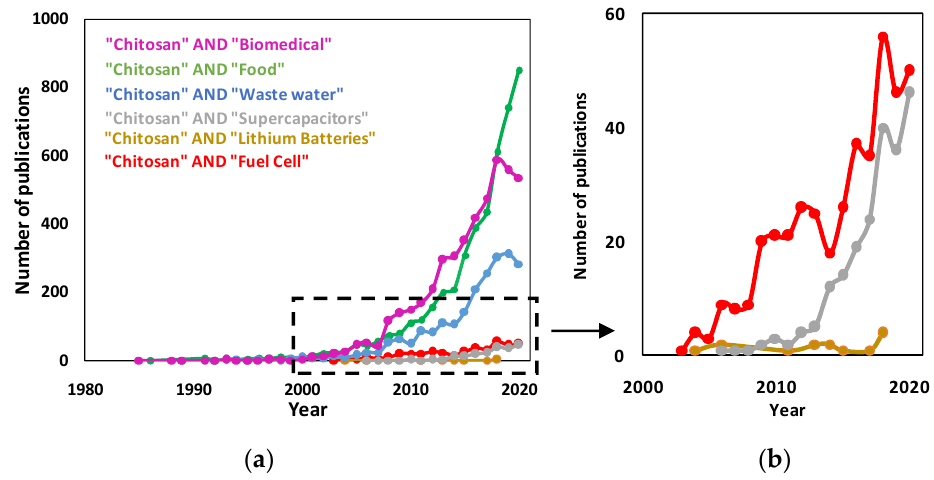
Figure 4. ( a ) Approximate number of publications from 1985 to 1st December 2020 obtained by Web of Science using the topic keywords indicated on the labels of the graph. ( b ) Magnification of the area indicated by the dashed box in the graph of panel ( a ).